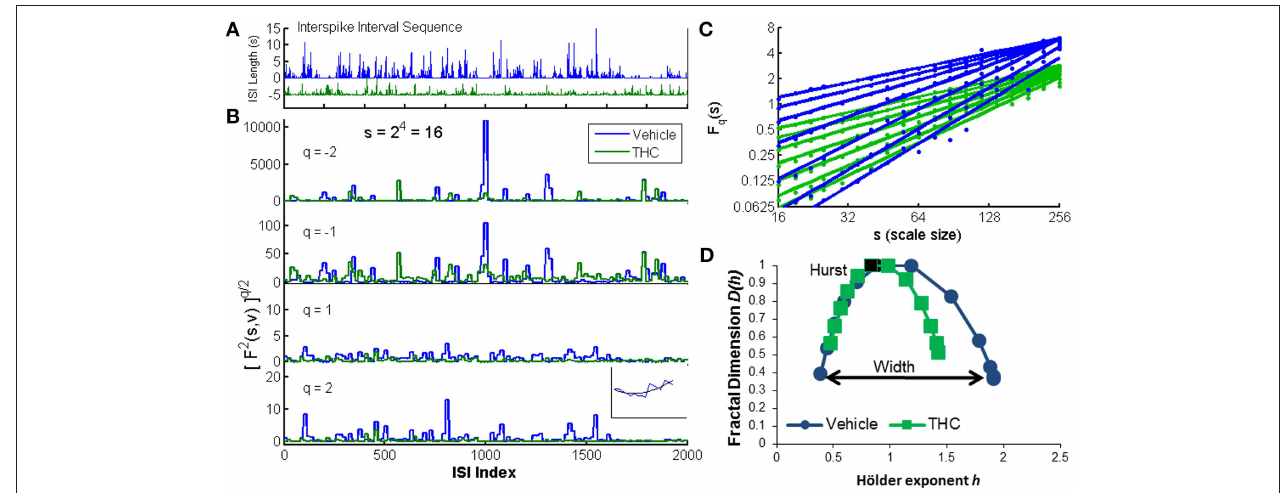
FIGURE 2 | Multifractal detrended fluctuation analysis. An illustration of the MFDFA method was created using one CA1 neuron recorded on two different days: one vehicle condition (blue) and one tetrahydrocannbinol (THC) condition (green). (A) The interspike interval sequence (ISI) of each neuron is shown for the first 2000 ISIs. Five seconds were subtracted from the entire THC ISI sequence for illustration purposes only. (B) The fluctuation function F is shown at scale 16 ( s = 16 ) for four different q-order statistical moments. Negative q-order statistical moments amplify small fluctuations, while positive moments amplify large fluctuations. Inset: F 2 ( v , s ) is the root mean-squared residual between the fit y v (black) of one segment s from the walk-like time series Y (blue). (C) The changes in variability across scales are indicated by variable slopes at different qth powers (integer q-values from − 3 to 3). The q-order Hurst exponent H(q) is the slope of each regression line. Blue lines are from the vehicle recording and green lines are from the THC recording. Dots indicate individual values from each scale (19 scales ranging from 16 to 256). (D) Multifractal complexity is visualized with the multifractal singularity spectrum. The Hurst exponent is closely related to the h- value at the apex of the singularity spectrum (black data points). The width is obtained by subtracting h- values at each end of the spectrum (independent of D(h) values) indicated by the black arrow. The singularity spectrum for the vehicle condition is wider than the THC condition, indicating THC decreases